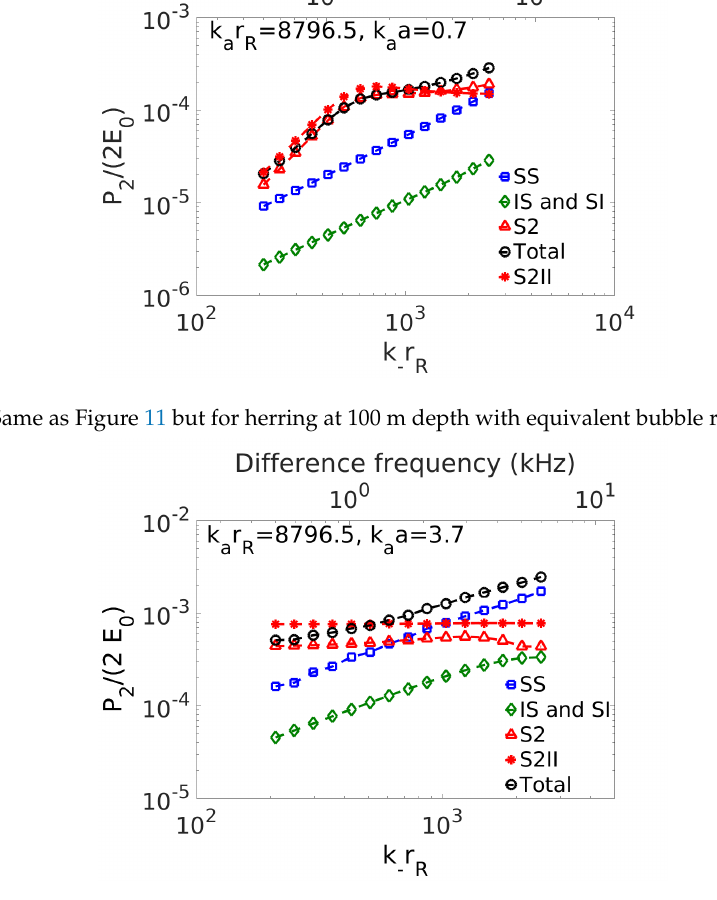
Figure 13. Equivalent to a cod at 100 m depth modeled as swimbladder with equivalent radius of roughly 4.2 cm with collinear incident waves of 21 kHz primary and varying difference frequencies propagating at ˆ i z using resonant bubble equation Equation (97) with cod damping. The difference frequency component of p 2 is calculated in backscatter at r R = − r R ˆ i z as a function of difference frequency through k − r R or k − a = k − r R k a a / k a r R . Upper abscissa shows the difference frequency for the current